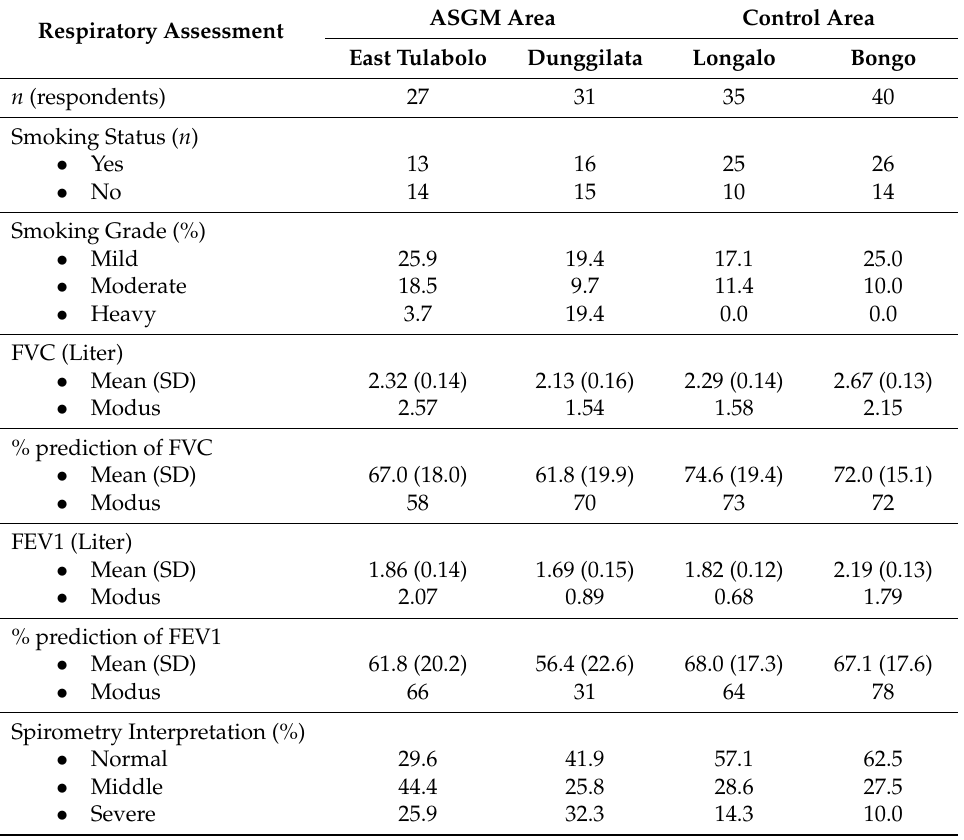
Table 2. Respiratory assessment result by smoking grade, Forced Vital Capacity (FVC), Forced Expiration Volume in 1 s (FEV1), and spirometry